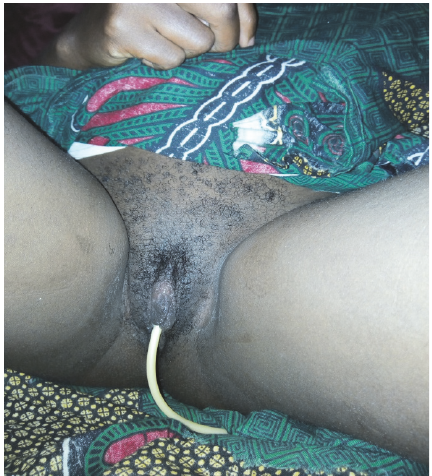
Figure 3: The vulvar edema resolved in day